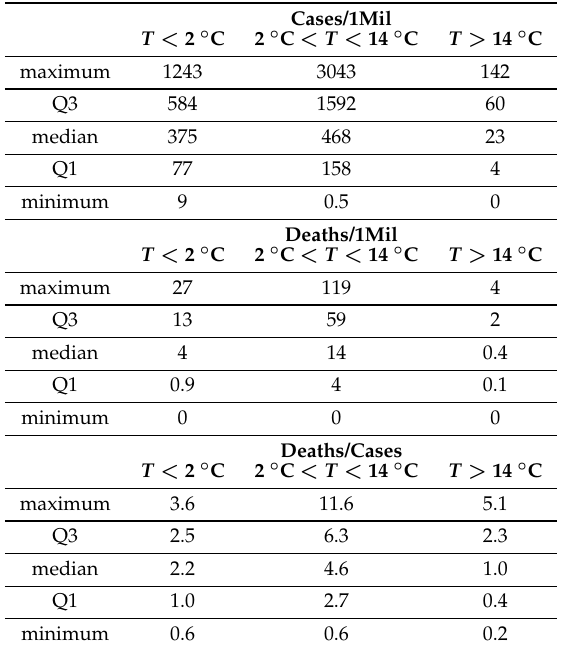
Table 6. Boxplot data: see Figure